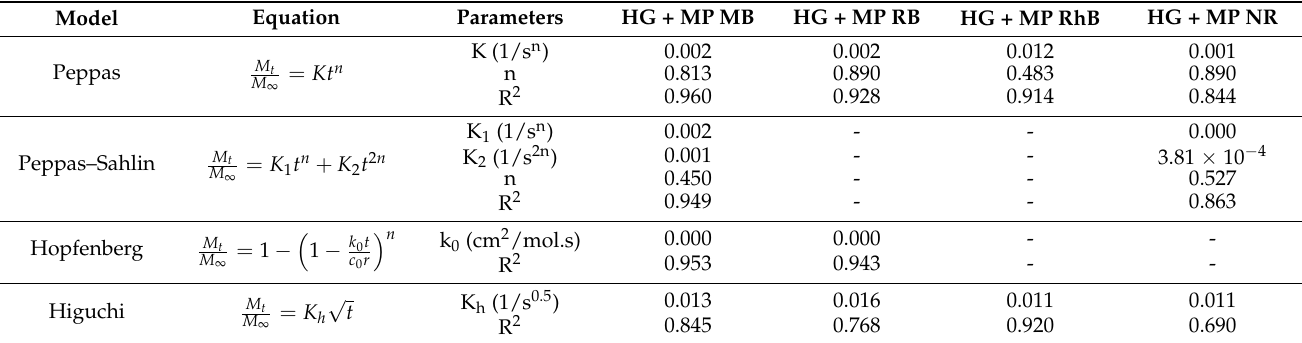
Table 3. Parameters obtained by fitting the Peppas, Peppas–Sahlin, Hopfenberg, and Higuchi to the release data of the dyes loaded in the microparticles incorporated in the SF